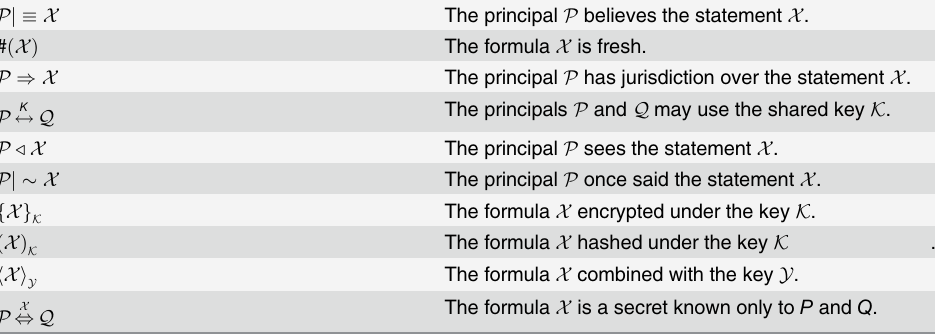
Table 3. Notations used in BAN